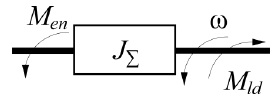
Fig. 3. Equivalent single-mass system